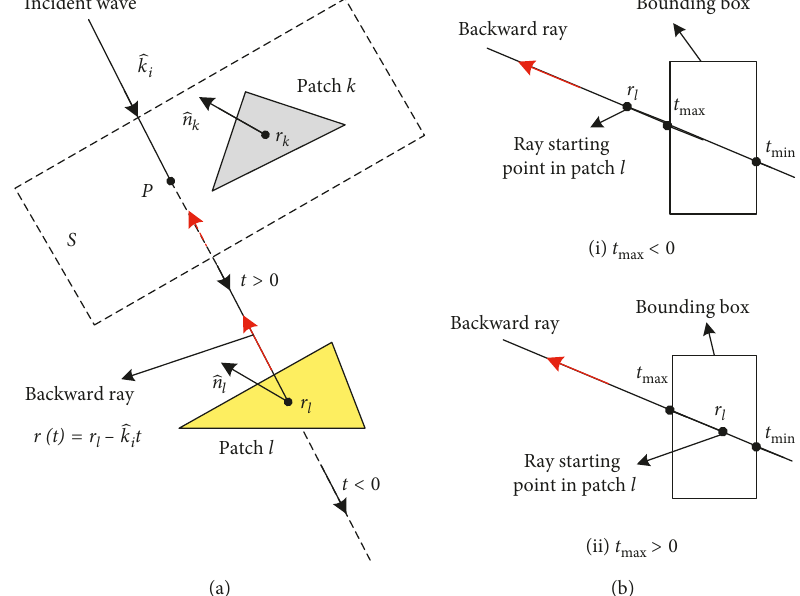
Figure 4: Visibility test of I t . (a) The relationship of shade between the patches. (b) The relationship of the incident ray and bounding box: vis ,l (i) t < 0 and (ii) t > max max